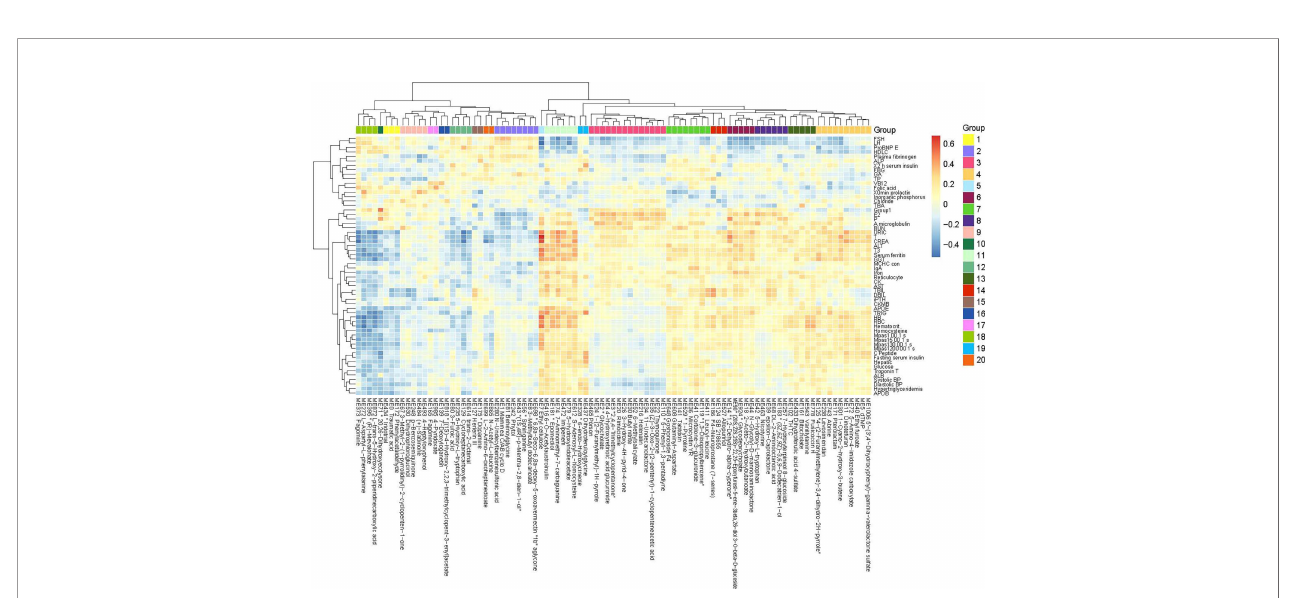
FIGURE 3 | Correlations between the urine metabolome and clinical parameters. Heatmap showing correlations between urine metabolomic groups and clinical parameters (Spearman correlation, p < 0.05, q < 0.05). Only metabolites correlated signi fi cantly with more than one clinical parameter are included in the heatmap (the complete heatmap showing all correlations is illustrated in Additional File 10: Figure S4 ). Color scale indicates the value of correlation coef fi